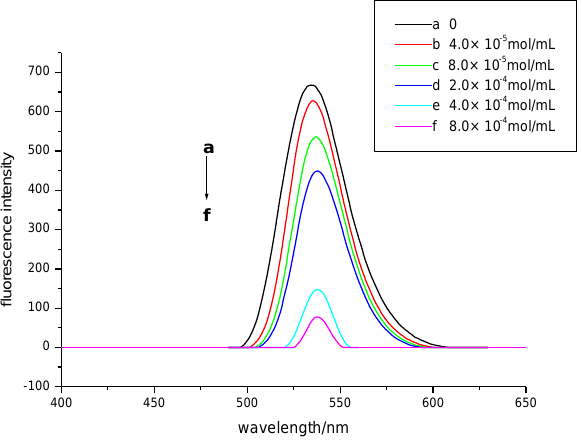
Figure 3. Fluorescence spectra of different concentrations of FEL interacting with CdTe QDs. The effect of the FEL dosage on the fluorescence quenching degree was investi- gated [27,28]. As shown in Figure 4A, the fluorescence quenching degree increased with increasing FEL dosage. The fluorescence quenching degree of the system reached the maximum (245.164 ± 0.0375, n = 3) when the dosage was 1.0 mL and tended to weaken when the dosage exceeded 1.0 mL. Therefore, the FEL dosage was controlled to be 1.0 mL in the